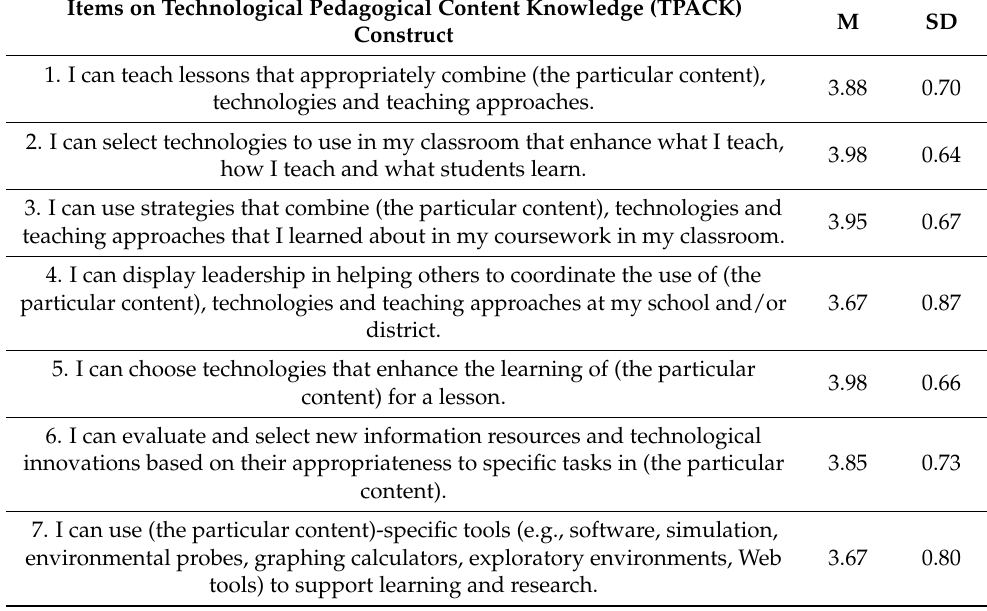
Table 3. Statistics on Technological Pedagogical Content Knowledge (TPACK) construct for all respondents.